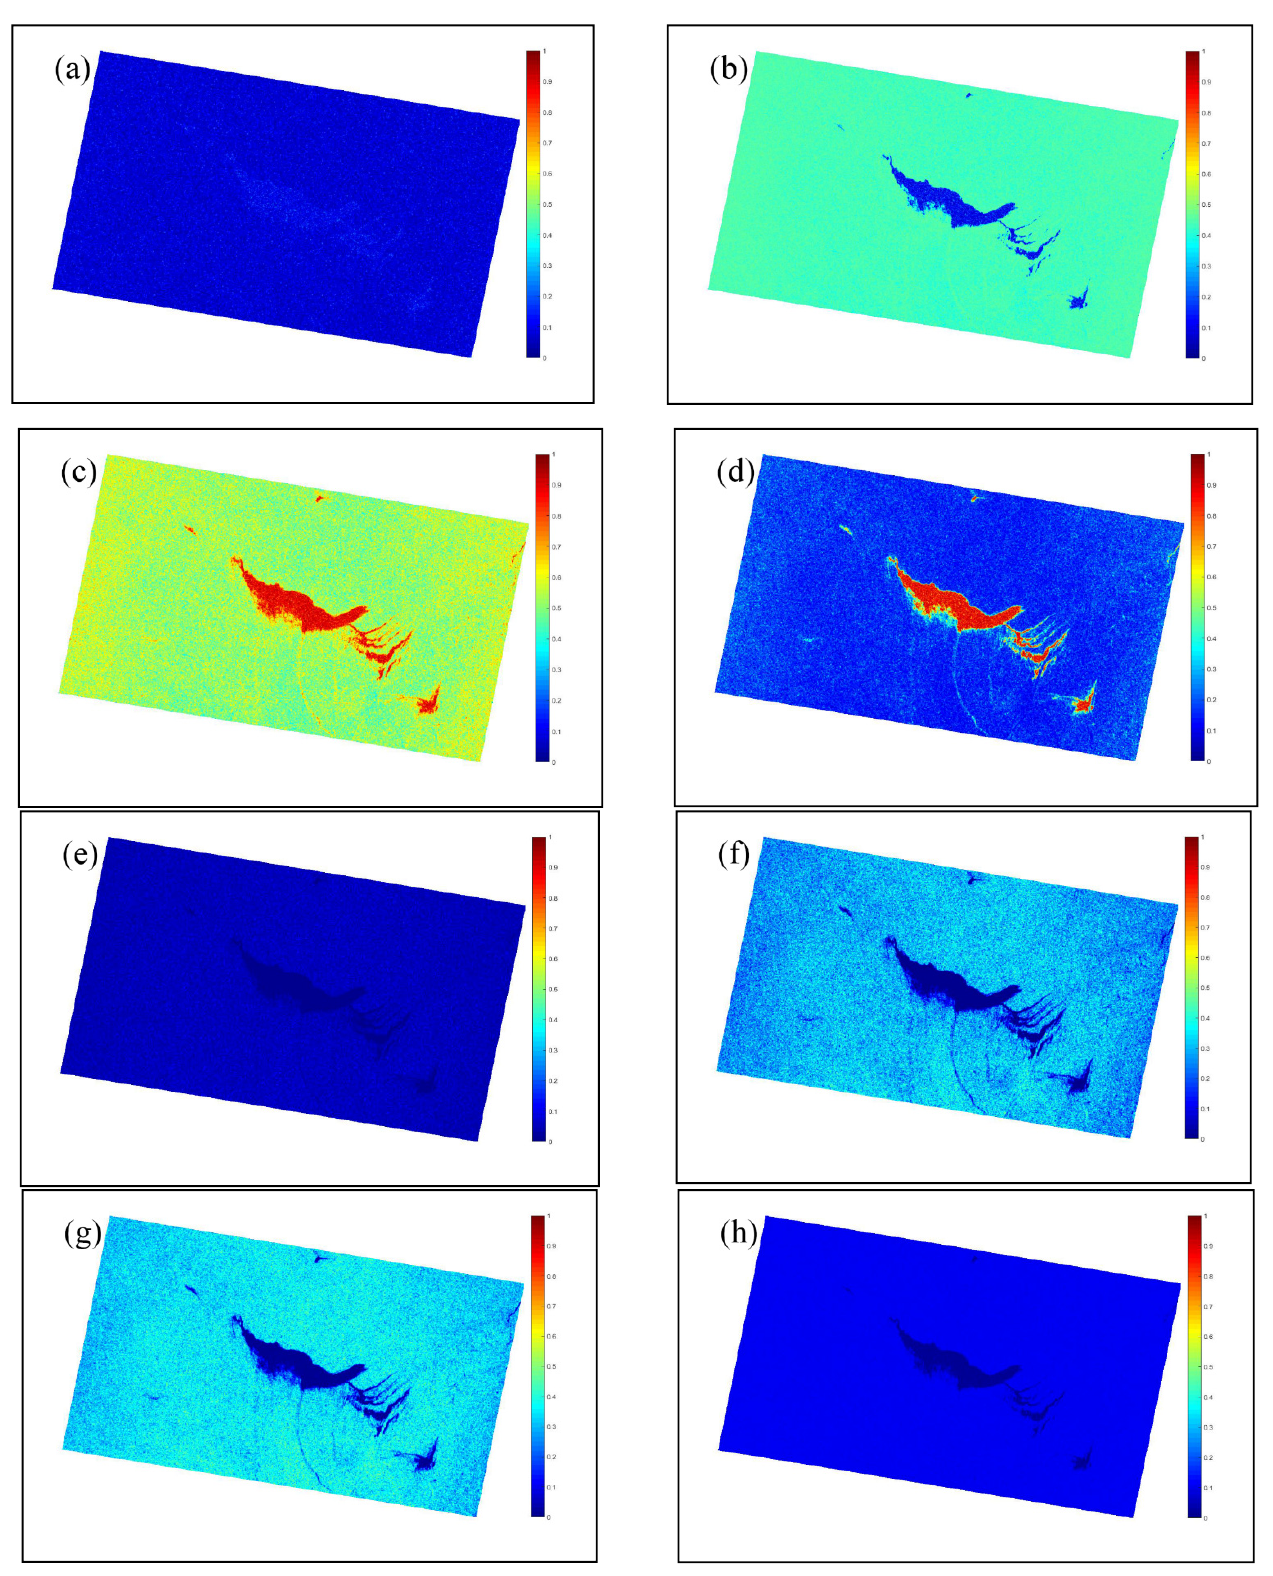
Figure 6. Visual images showing the combination parameters H _ A and H _ A 12 . ( a ) H * A . ( b ) H * A 12 . ( c ) H *(1 − A ). ( d ) H *(1 −